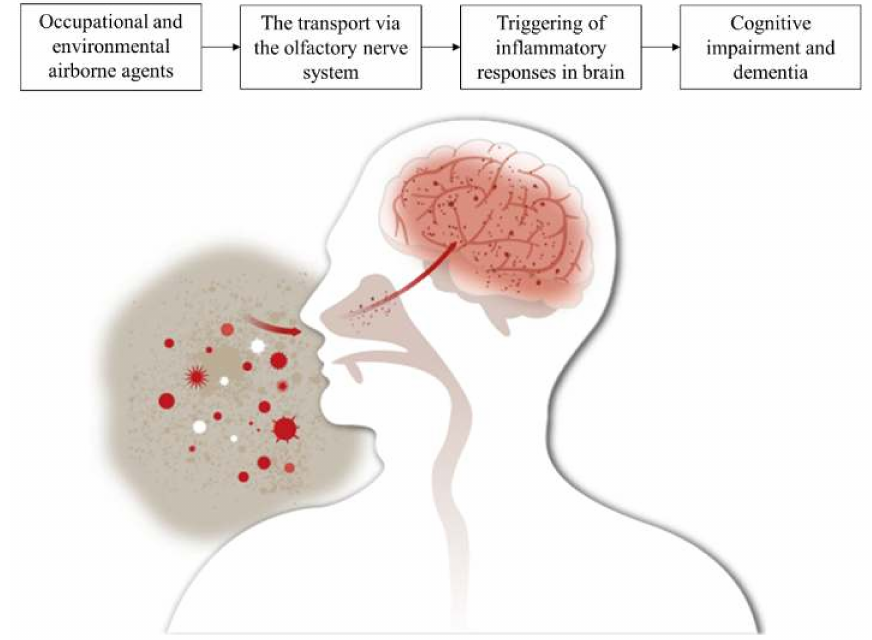
Figure 2. The mechanism of cognitive impairment and dementia from inhaled external airborne agents.